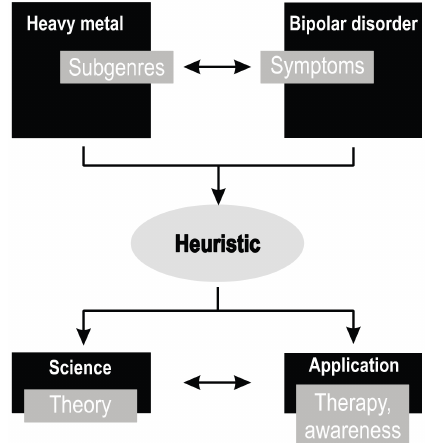
Figure 1. Analogous model showing the heuristic value of heavy metal to portray the symptoms of bipolar disorder. Shown is also the potential of this analogous model to inspire theory development in science and its applied value for clinical therapy and increasing public awareness of mental health disorders. The model also shows that heavy metal and bipolar disorder and theory and application can potentially inform each other (bidirectional